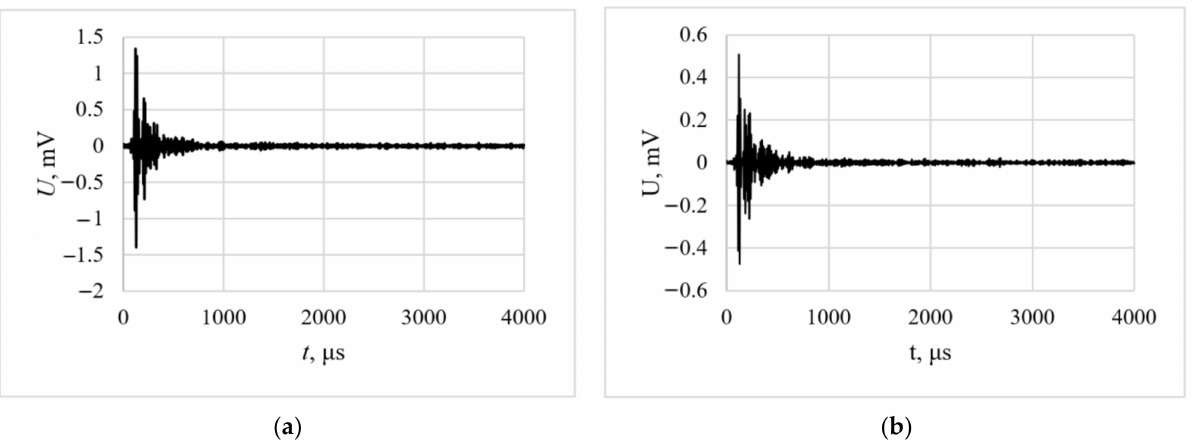
Figure 12. Typical AE signal waveforms of a specimen with diffusion layers at σ max = 300 MPa ( a ) and σ max = 400 MPa ( b